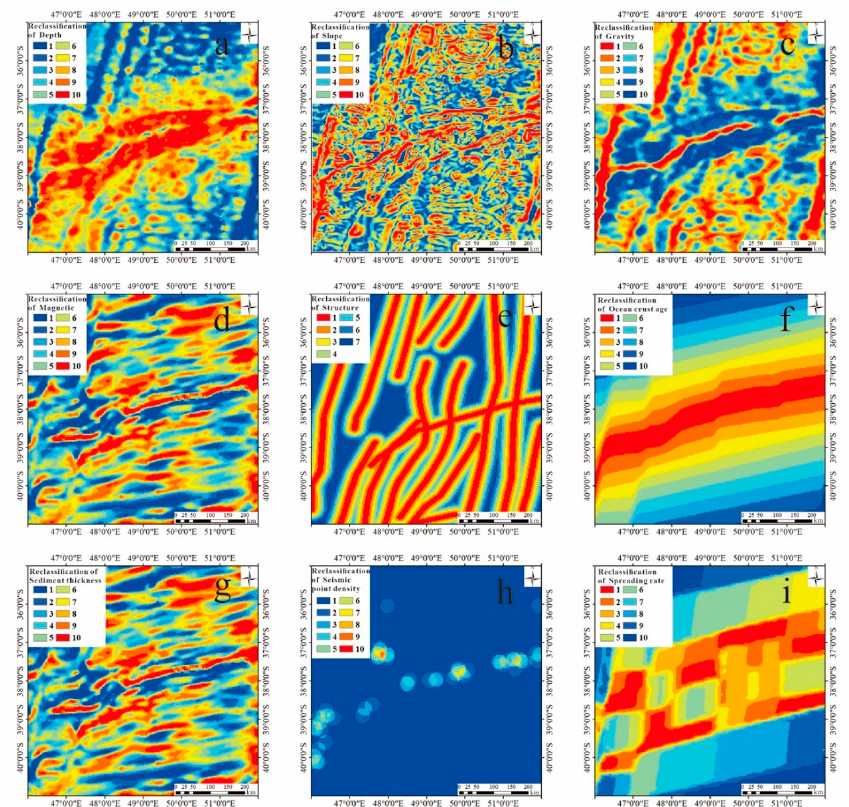
Figure 3. Reclassification of evidence layer.( a ) Water depth; ( b ) Slope;( c ) Gravity; ( d ) Magnetic; ( e ) Structure; ( f ) Ocean crust age; ( g ) Sediment thickness;( h ) Seismic point; ( i ) Spreading rate.